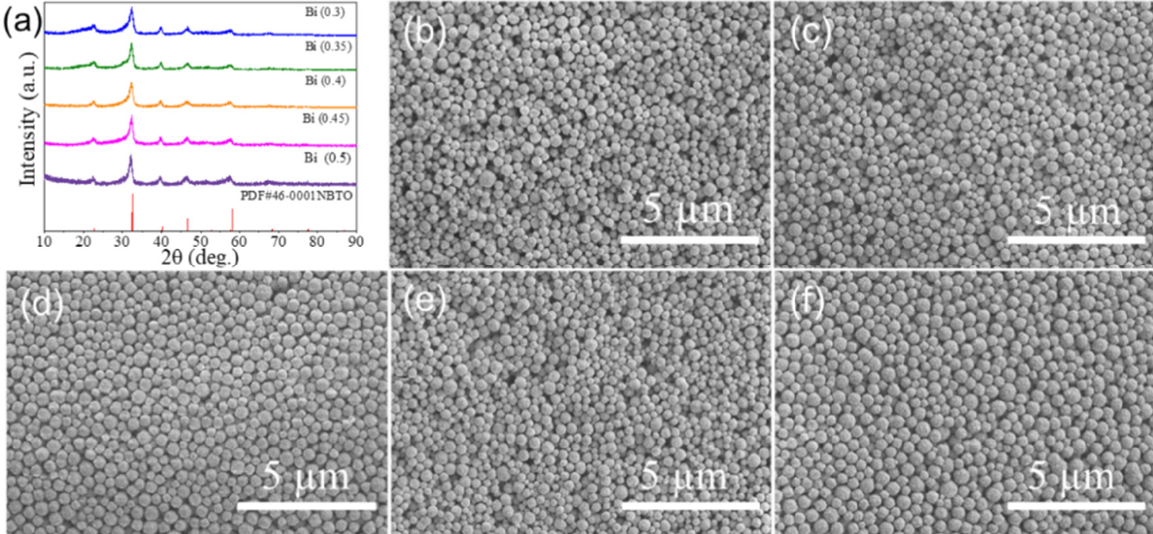
Figure 1. ( a ) XRD patterns and ( b − f ) SEM images of the Na 0.5 Bi x TiO 3